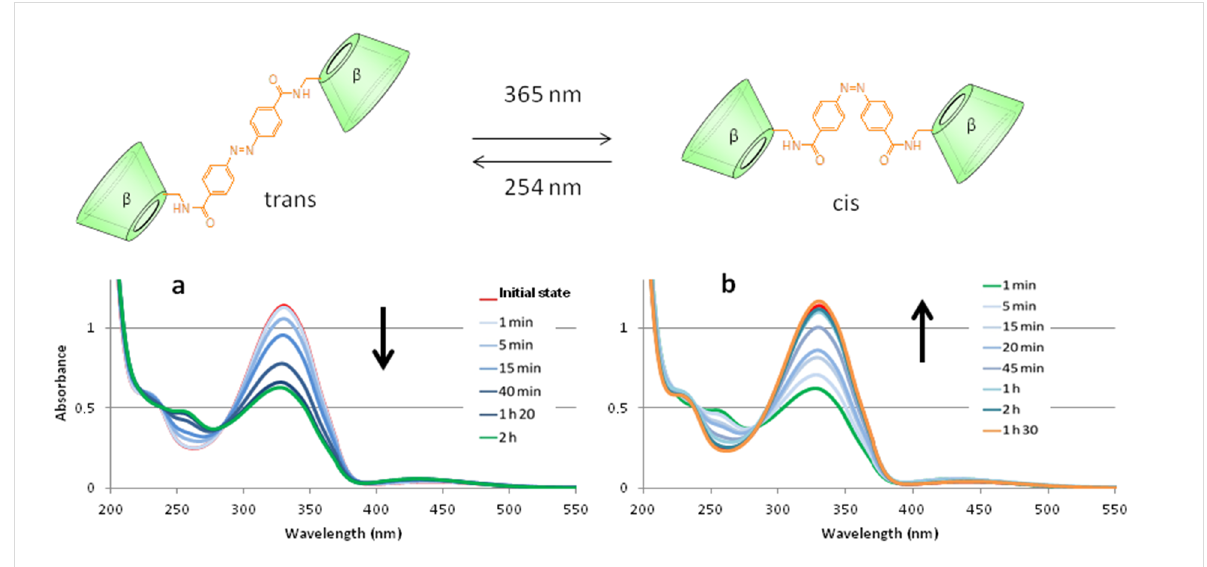
Figure 1: Overlaid UV spectra of the irradiation of AZO-CDim 1 (a) from 0 to 120 min at 365 nm and then (b) from 0 to 90 min at 254 nm; ( c = 10 − 4 M, water, 6 W lamp).